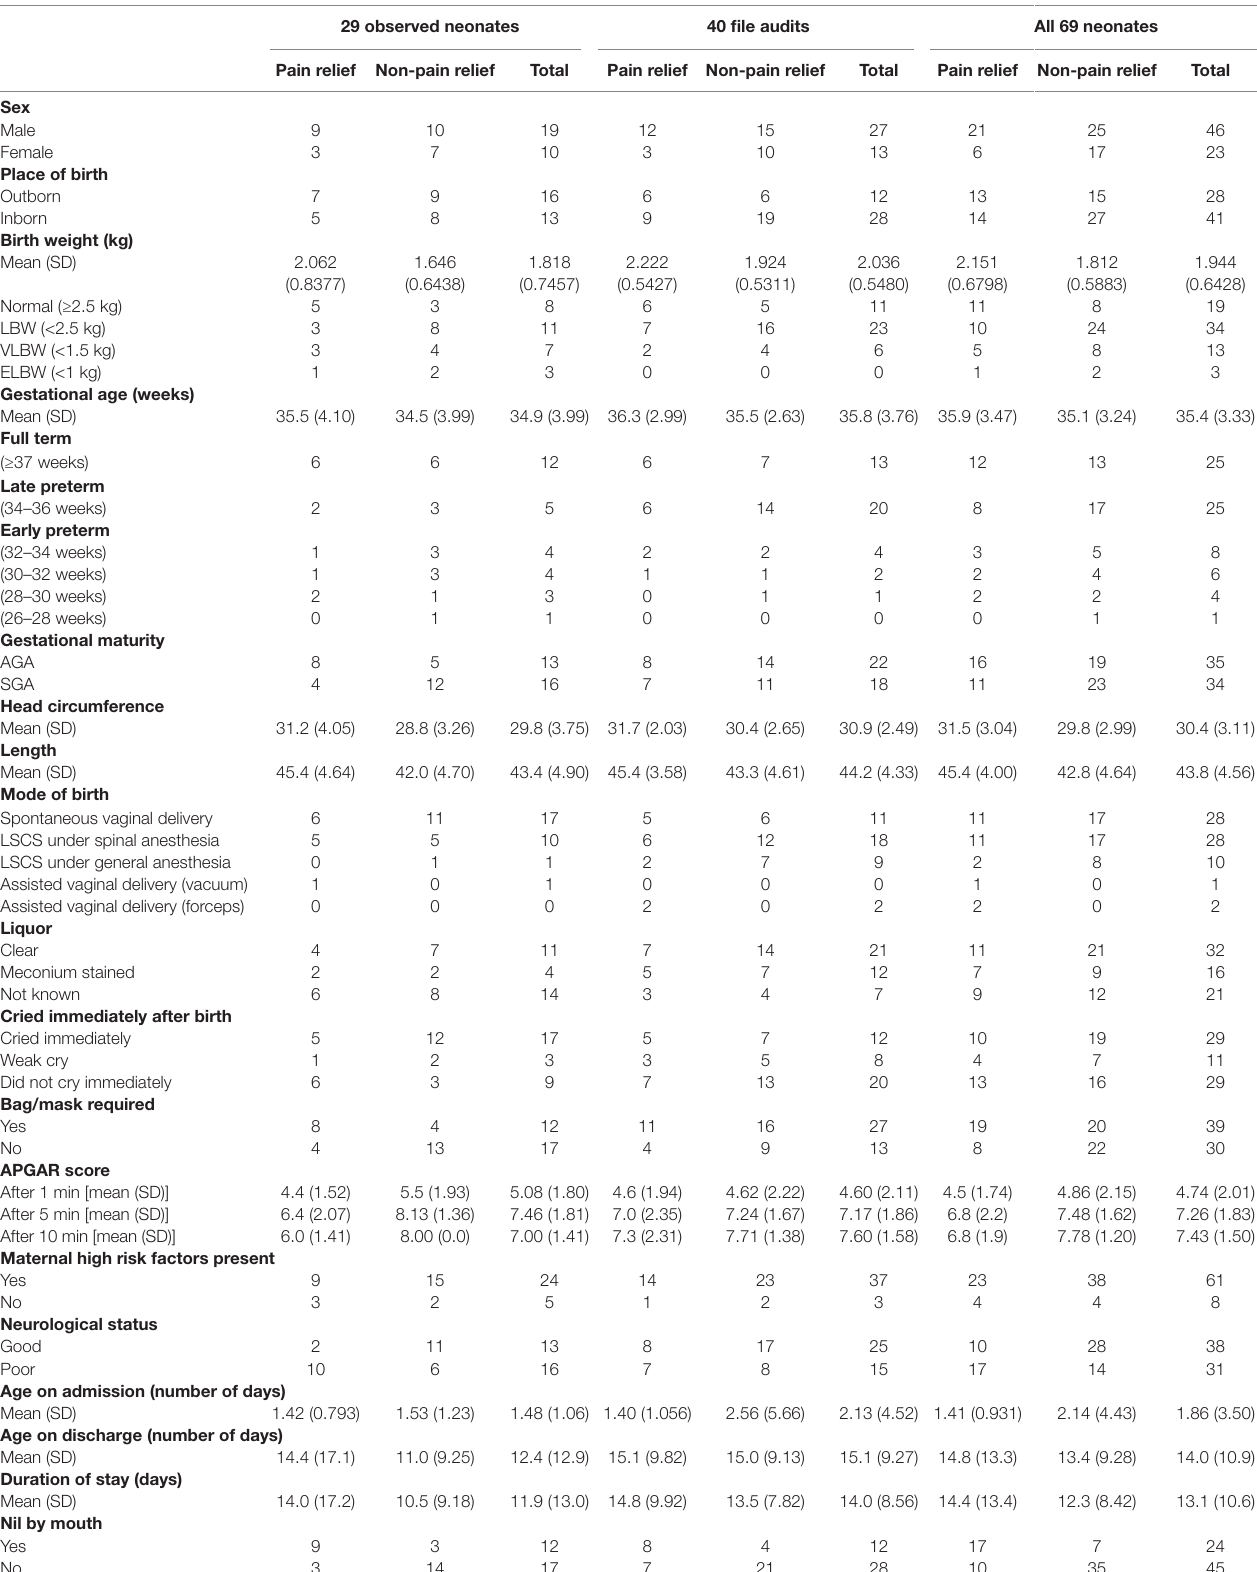
TaBle 1 | sociodemographic and clinical profile of